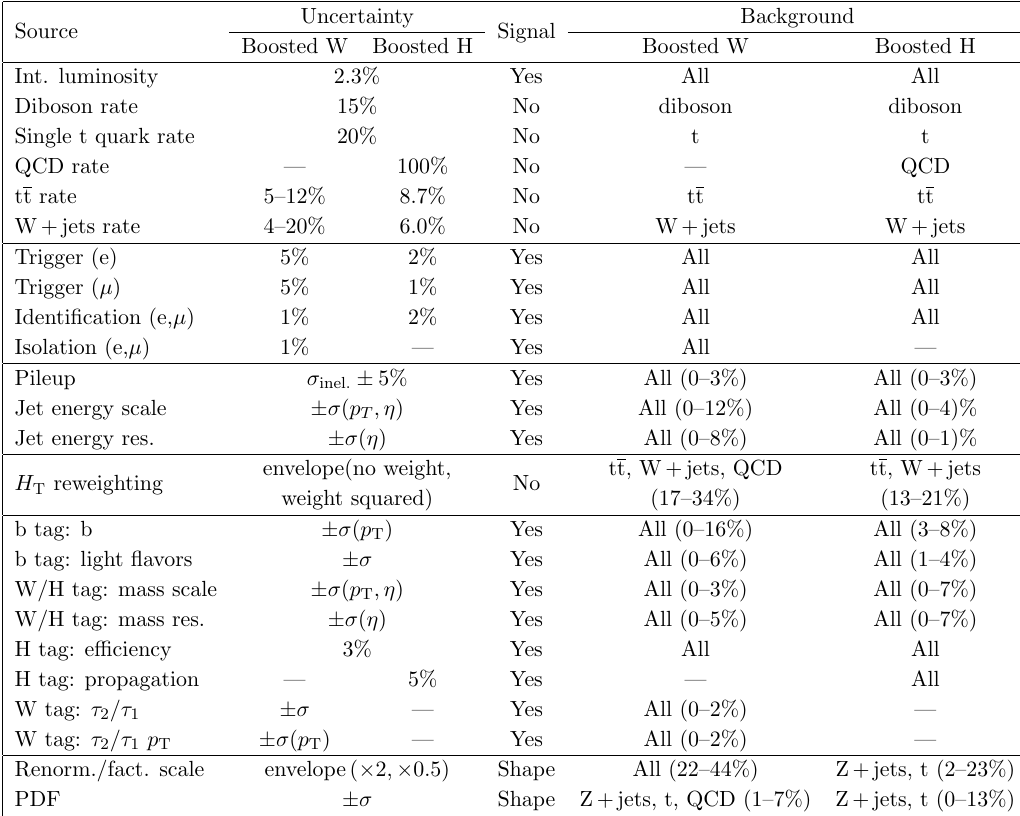
Table 2 . Summary of the systematic uncertainties, along with numerical values and application to signal and/or background samples. The second column gives the magnitude of normalization uncertainties or the procedure used to evaluate shape uncertainties. The symbol (cid:27) indicates one standard deviation of the corresponding systematic uncertainty. Renormalization and factorization energy scale uncertainties are treated as shape-only for signal but include normalization uncertain- ties in background. Values stated for shape uncertainties indicate a representative range over the categories for the dominant backgrounds and/or